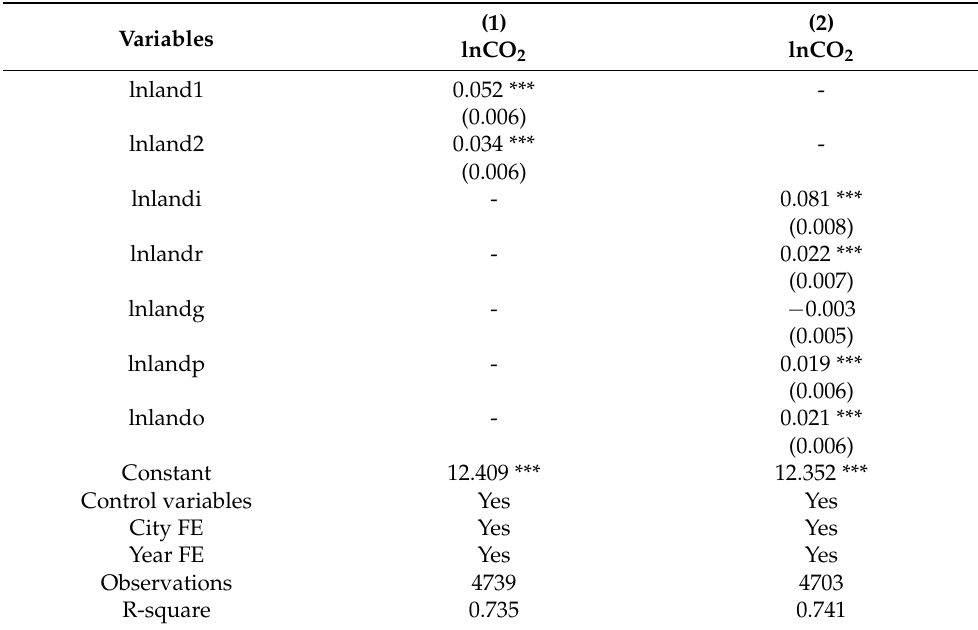
Table 6. The results of mechanism